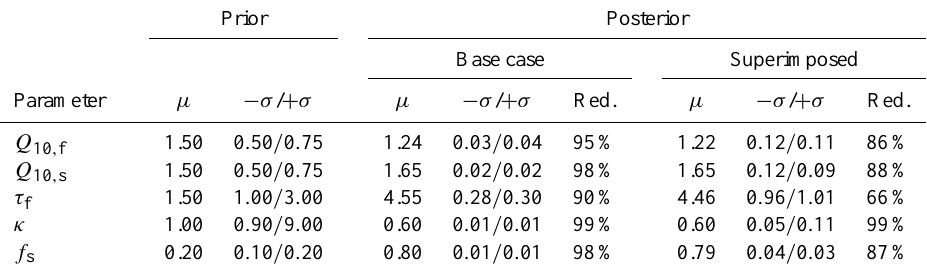
Table 1. Prior and posterior parameter values including their uncertainties for five global parameters. Upper and lower percentiles equivalent to one standard deviation are given (i.e. µ − σ is equivalent to the 15.9th percentile and µ + σ is equivalent to the 84.1th percentile). The relative reduction in uncertainty (Red.) related to + σ is also shown. Prior and posterior parameter values for the β parameters are provided in Table S2. Units: τ f , years; all others unitless.